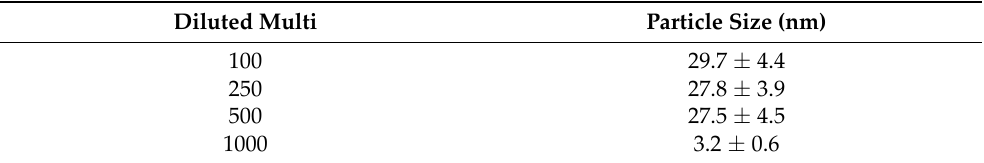
Table 9. The effects of different dilution multi on the efficiency of self‑microemulsifacation of GTP‑